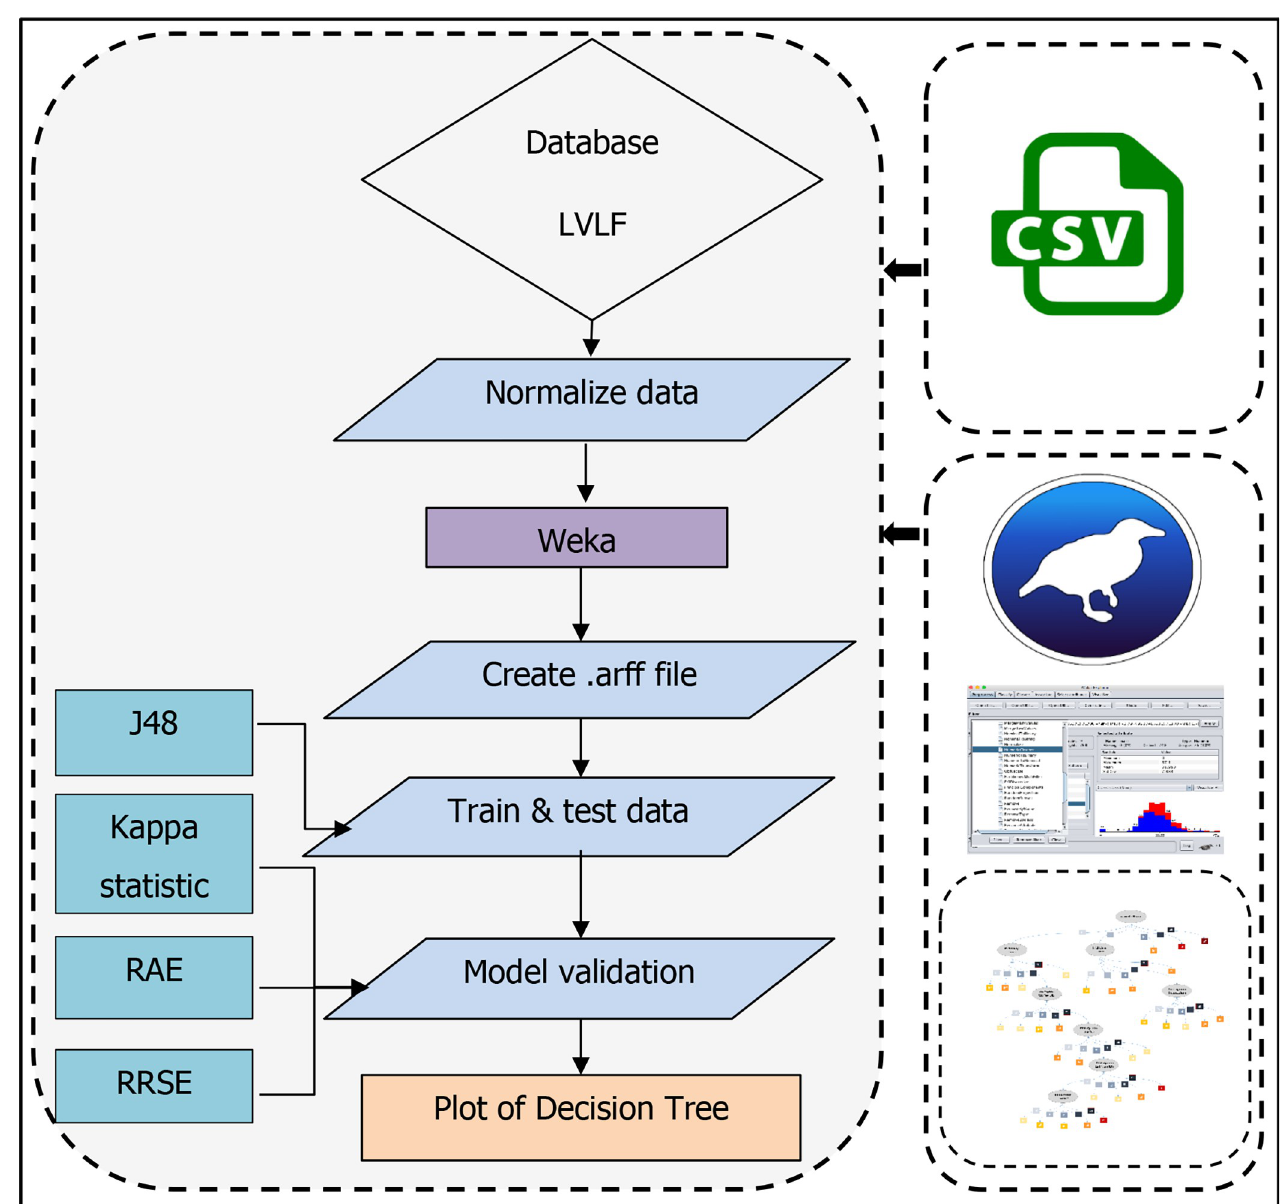
Fig 8. Computation process of